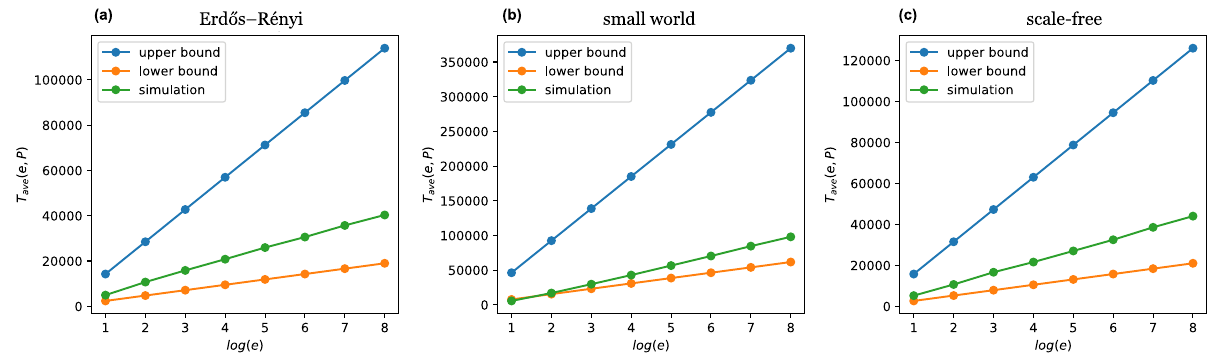
Figure 3. Upper and lower bounds of the e-averaging time , T avg , defined by Boyd et al. 1 and the T avg calculated through simulations in ( a ) Erdős-Rényi, ( b ) small world and (c) scale-free graphs with n 20 deg avg =